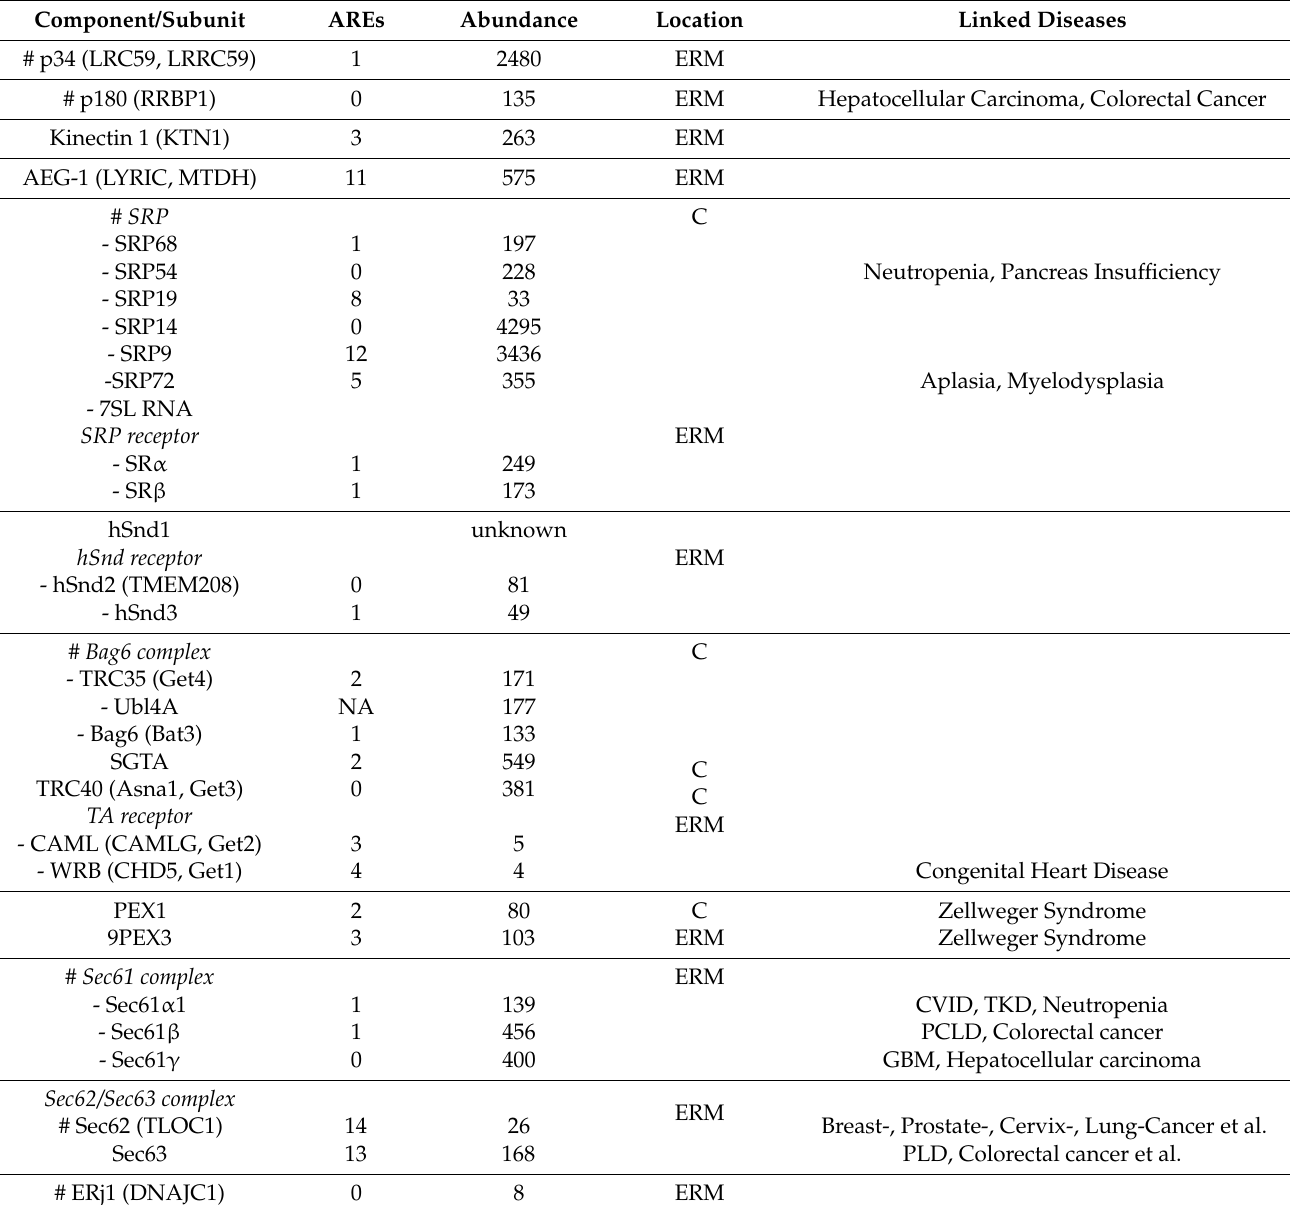
Table 1. Protein targeting and transport components/ complexes in HeLa